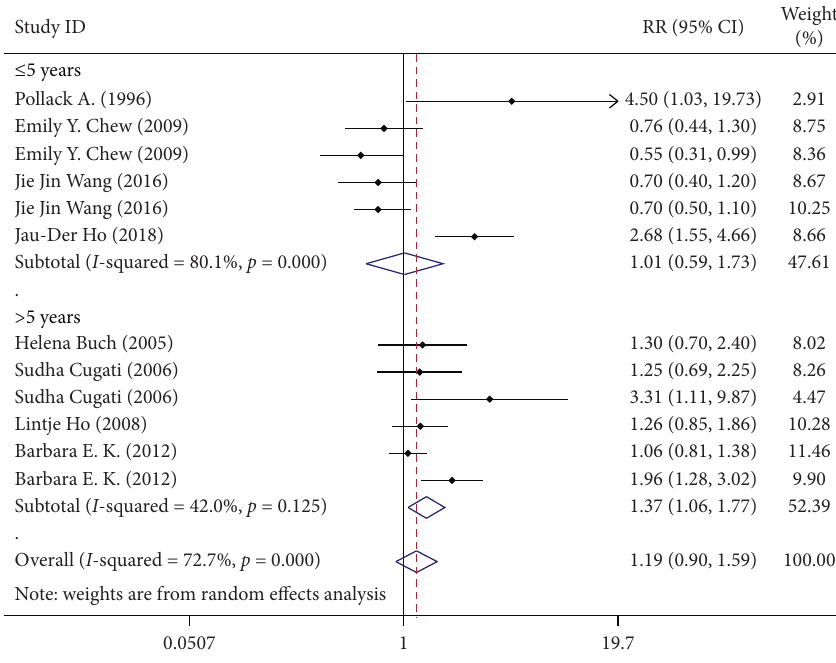
Figure 8: Subgroup analysis on follow-up